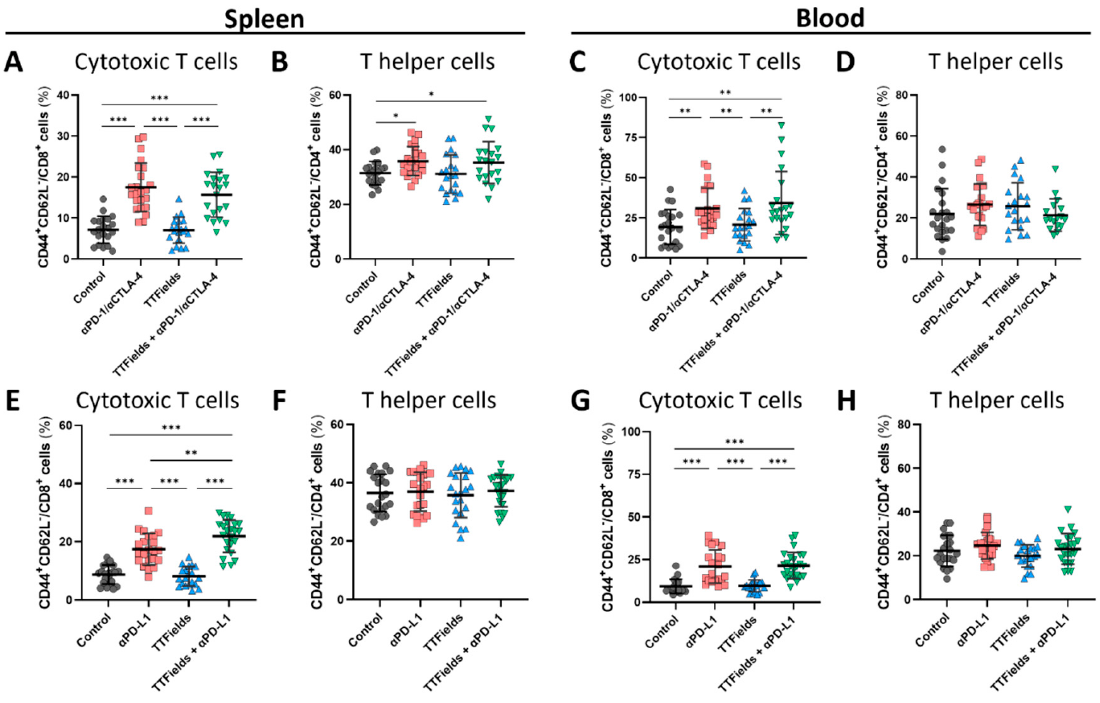
Figure 5. TTFields application did not impede ICI-derived formation of splenic and blood effector memory cytotoxic T cells. Spleen ( A , B , E , F ) and blood ( C , D , G , H ) were collected from the anti-PD- 1/anti CTLA-4 ( α PD-1/ α CTLA-4) experimental set mice ( A – D ) and from the anti-PD-L1 ( α PD-L1) experimental set mice ( E – H ), and analyzed for the percentages of effector memory cytotoxic (CD3 + CD8 + ) ( A , C , E , G ) and helper (CD3 + CD4 + ) ( B , D , F , H ) T cells. Values are mean ± SD. * p < 0.05, ** p < 0.01, and *** p < 0.001; Student’s t -test.